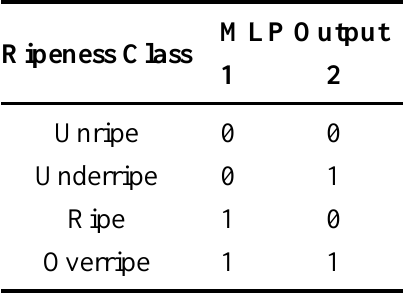
Table 3. Output coding representations for CC and CD combinations.